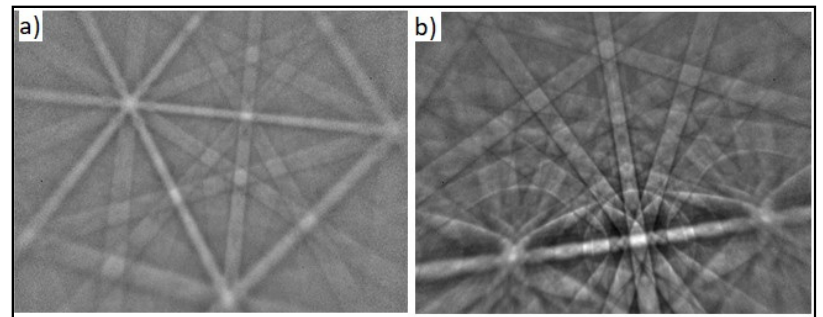
Figure 1. SEM image with the EBSD analysis of an NiTi-1 sample (0.5 um scale): ( a ) NiTi cubic phase; ( b ) Ni 3 Ti hexagonal phase.